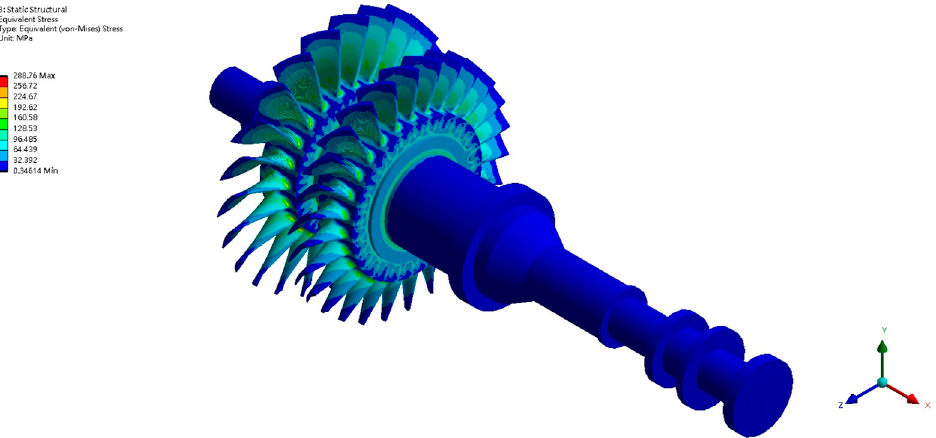
Figure 12. Stress result of TRT rotor centrifugal force analysis.